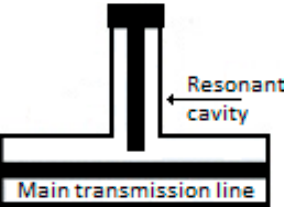
Figure 5. Typical microwave coaxial resonator structure.